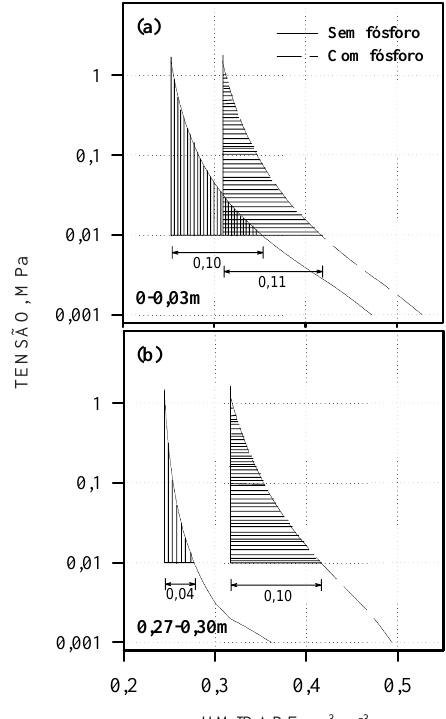
Figura 1. Curvas de retenção de água de material de solo, com e sem P, em duas camadas do solo.